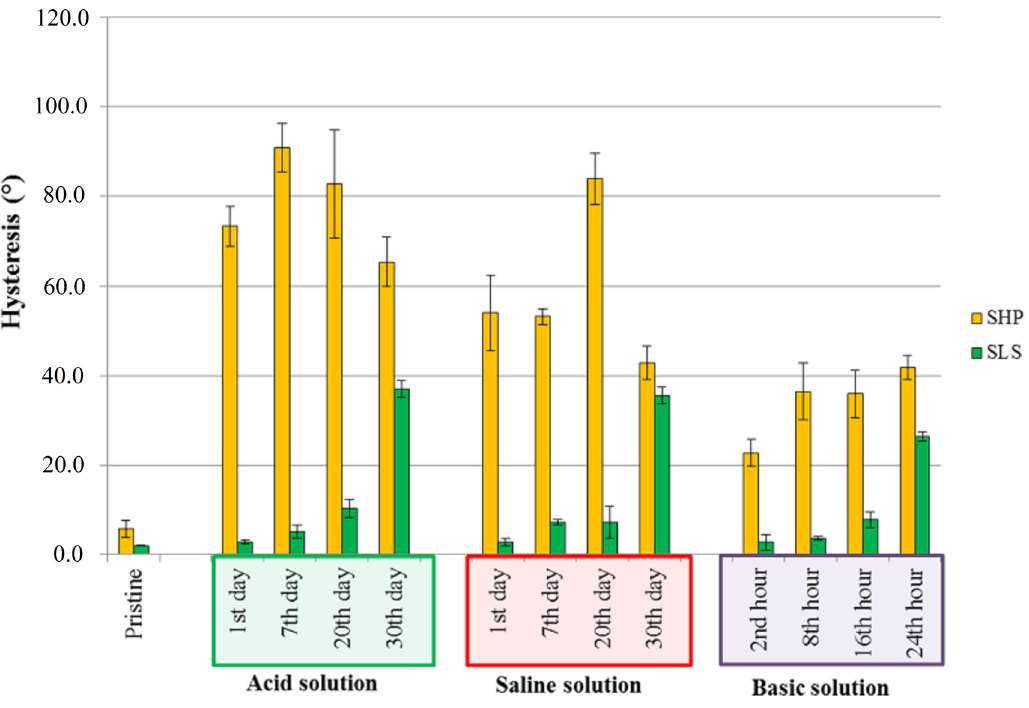
Figure 7. Hysteresis of SHP and SLS after aging in acid, saline and basic solutions.